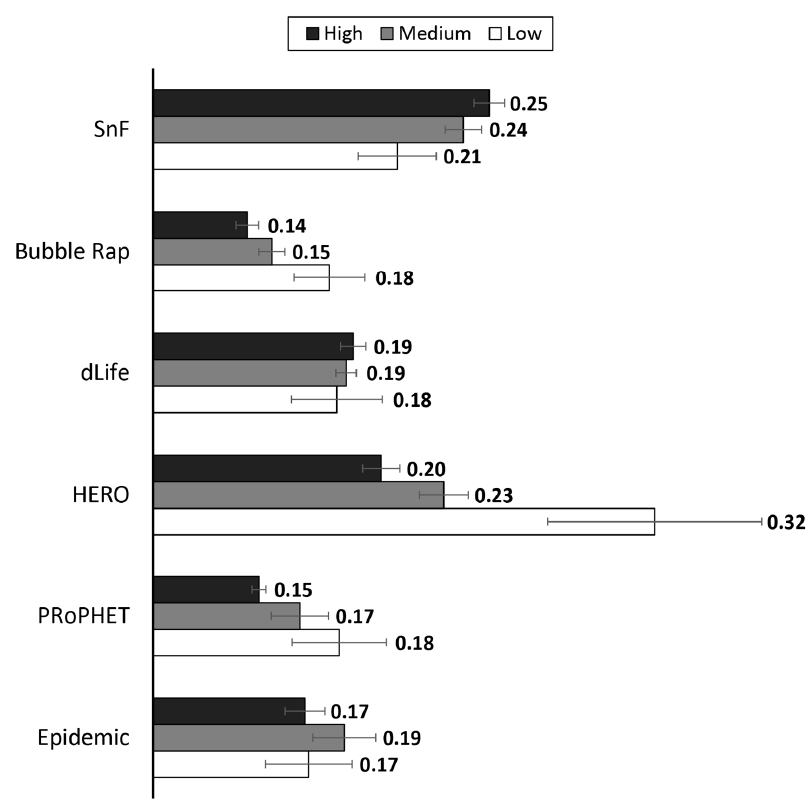
Figure 4. Energy distribution ( (cid:2009) ) under low, medium and high degrees of spatial locality. Overall, SnF records the highest energy distribution, with the central nodes consuming only about four times as much energy as the other nodes under the different degrees of spatial locality. By greedily spraying message copies, nodes are selected as relays irrespective of their forwarding ability. This distributes the task of finding more suitable relays across a wider range of nodes. Also, energy distribution increases with spatial locality since the chosen number of message copies to spray is increased. In real-world implementation, however, determining the number of copies to spray may require knowledge about global network parameters (e.g., total number of networking nodes). Also, further uncertainties are introduced under realistic human movement patterns that demonstrate high degrees of spatial locality.